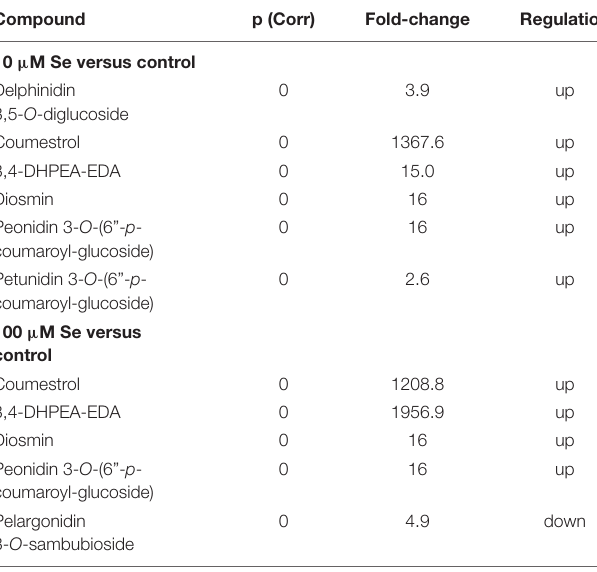
Differential phenolics are presented as Bonferroni corrected p, fold-change (absolute values, in either 10 or 100 µ M Se versus control) and regulation. According to the software Mass Profiler Professional 12.06 used, p-values of 0 and fold-change values of 16 denote extremely high significance or fold-change,